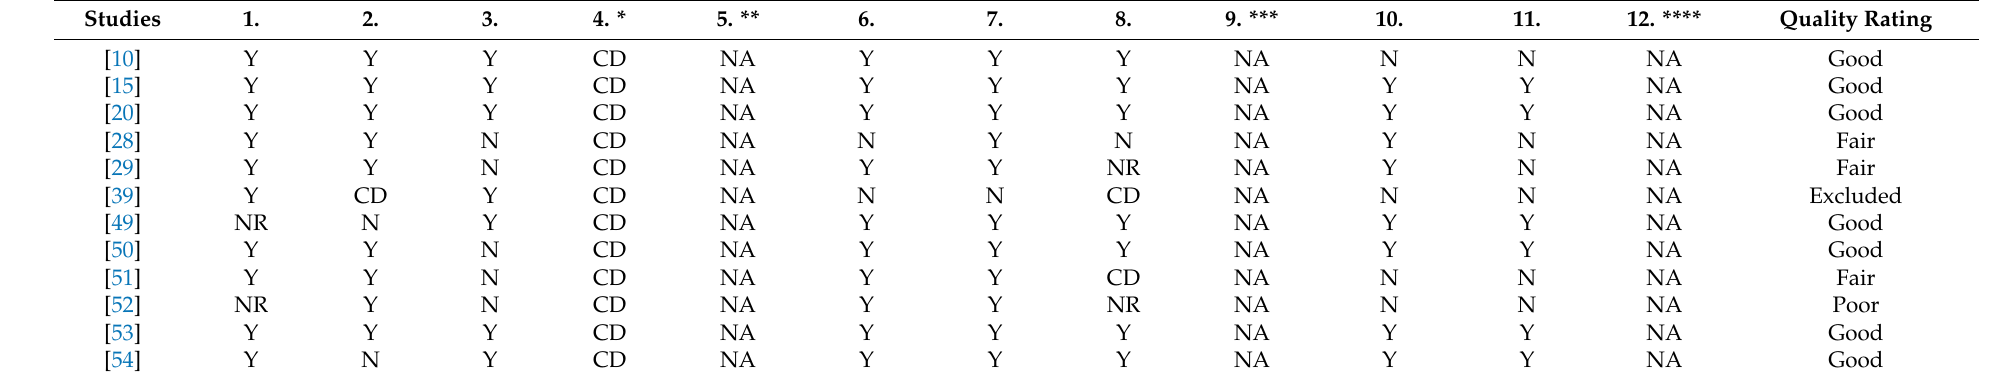
Table 2. Results of quality assessment of the Before-After (Pre-Post) studies (Help-professionals Data). Studies